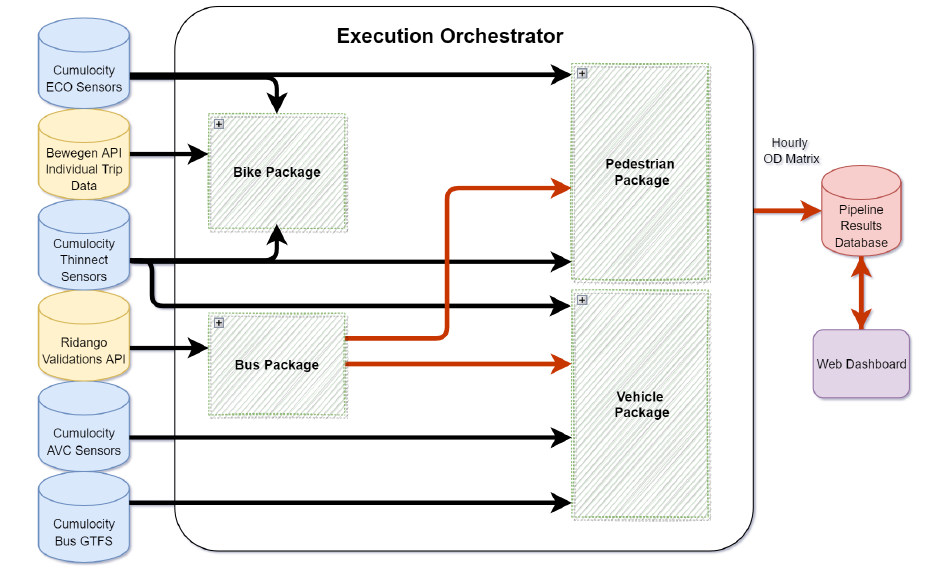
Figure 2. The proposed system